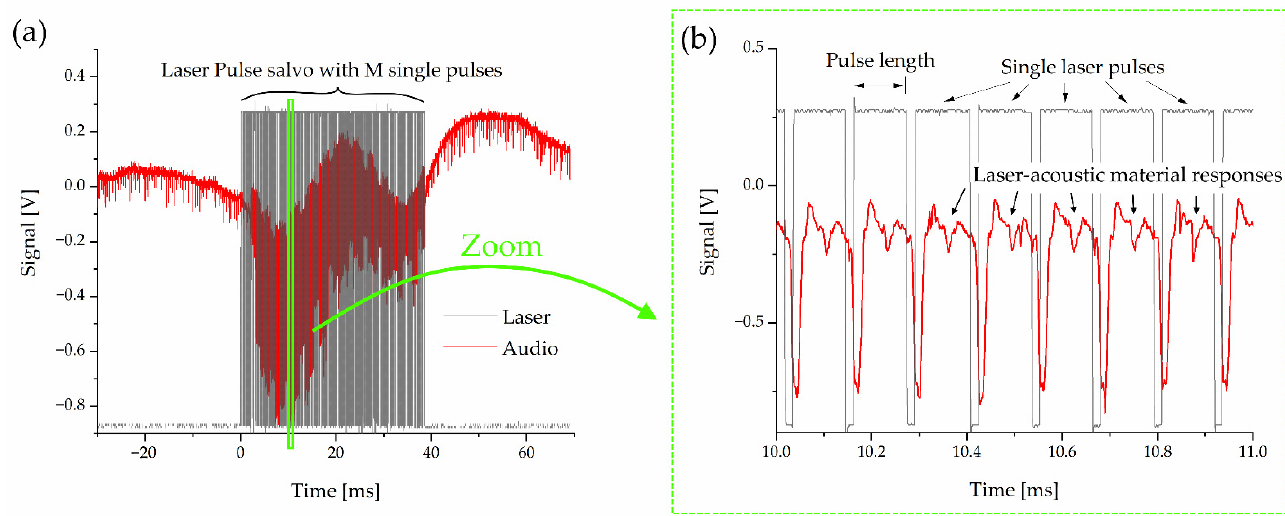
Figure 3. Signals recorded by the oscilloscope during one data-acquisition step ( a ): a laser-pulse salvo ( grey ) consisting of M (default: M = 300) single pulses lead to an acoustic response of the material ( red ). The zoom in ( b ) reveals single laser pulses (default length = 110 µs), each generating one high-frequency laser-acoustic material response.